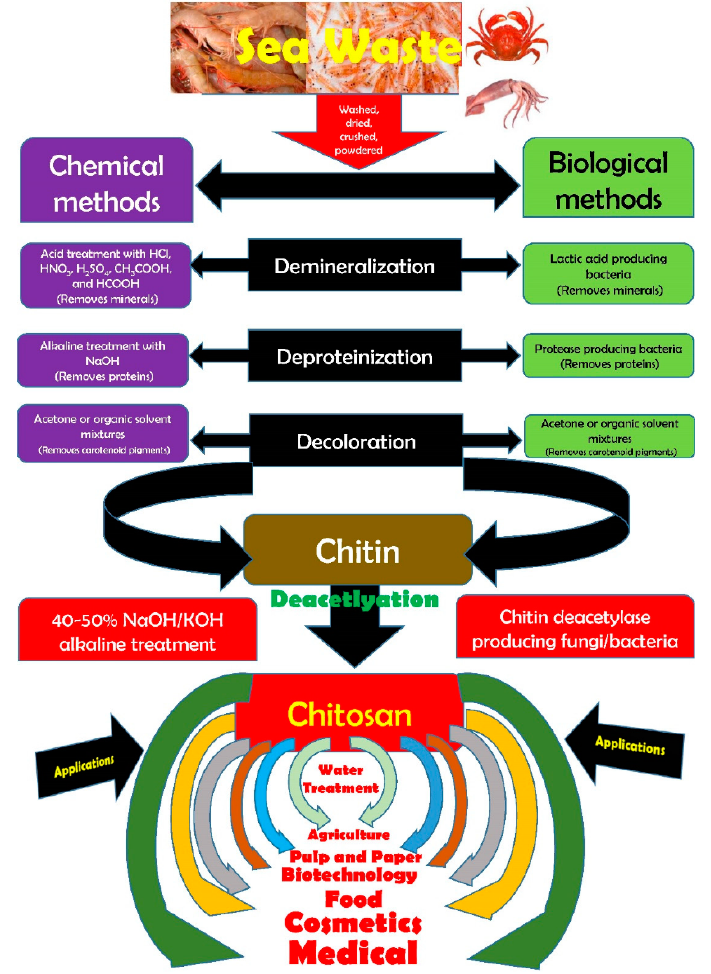
Figure 5. Modalities for the synthesis of chitosan and its applications (taken from [12] under Creative Commons License).